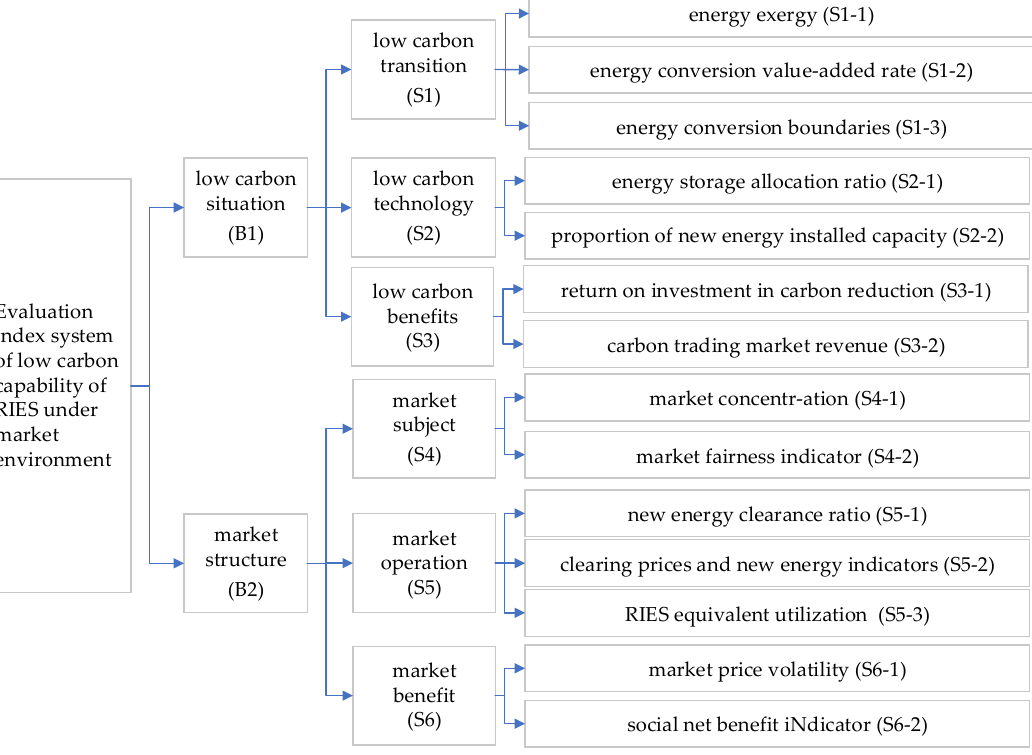
Figure 2. CRIES low-carbon capability indicator system.